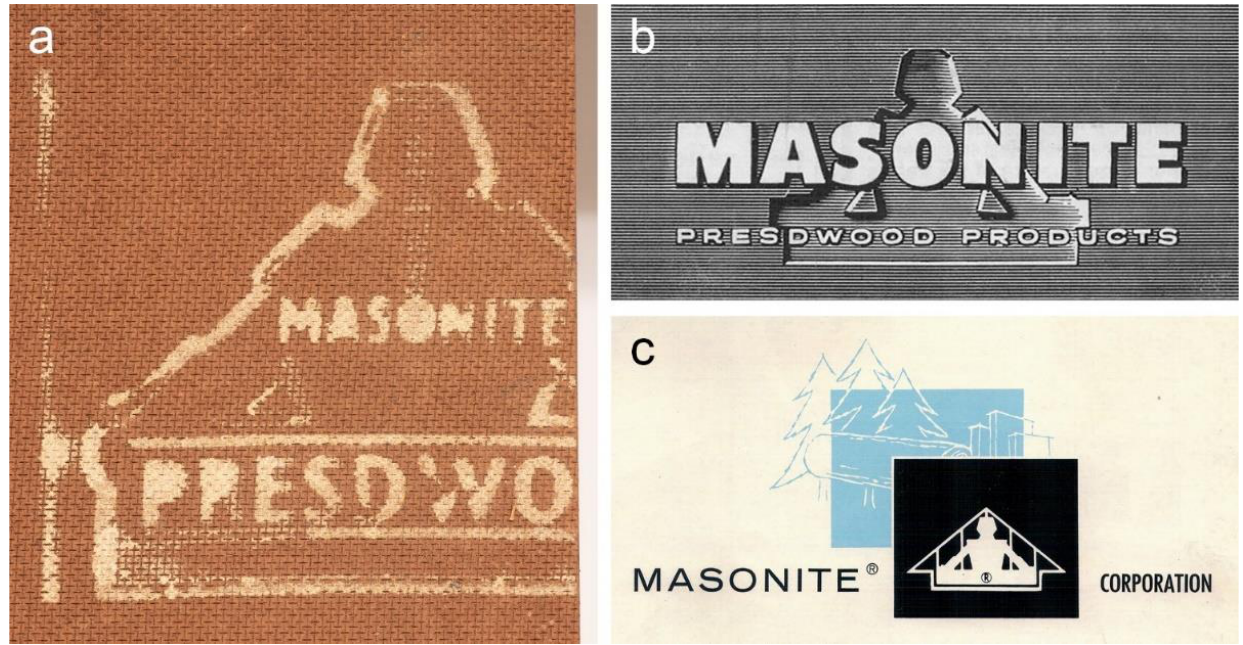
Figure 5. Detail showing the Masonite ® Presdwood ® stamp on the reverse side of Mount Huangshan , 1983 ( a ). Masonite ® Presdwood ® brand sign featuring the “Masonite Man” from the ( b ) 1950 and ( c ) 1960 Masonite Corporation advertisements.